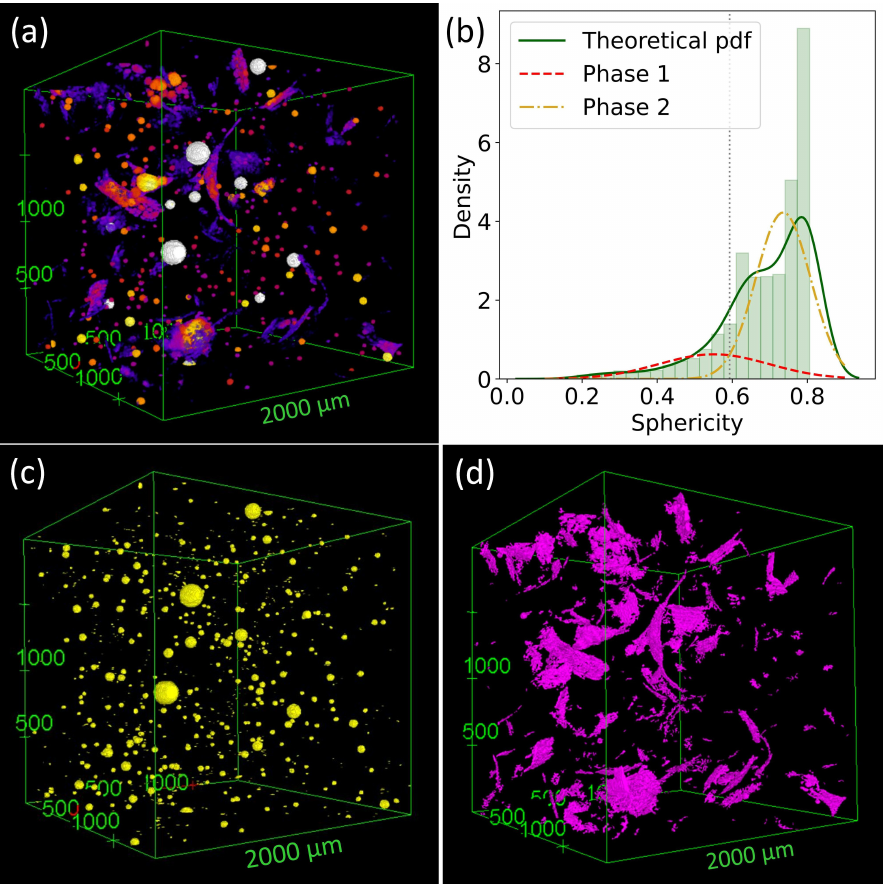
Figure 8. 3D Micro-CT image analysis of KGP-0.5%PAN-WG: ( a ) Microstructure. ( b ) Histogram of sphericity of particles. ( c ) Pore structure. ( d ) Fiber